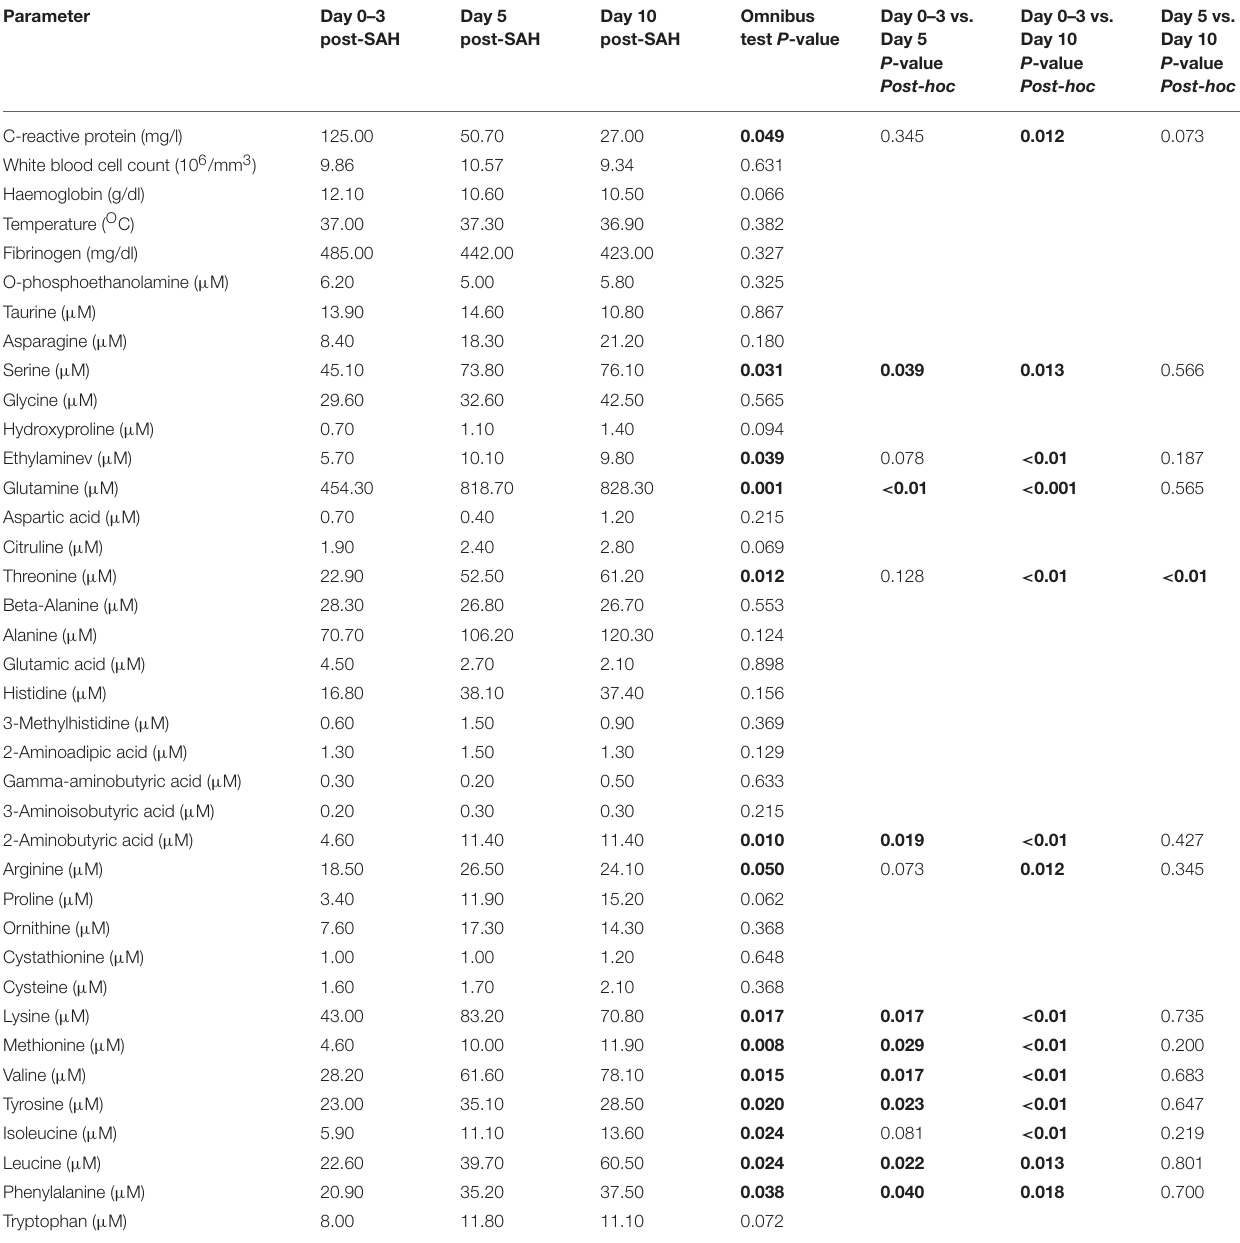
TABLE 4 | Amino acid level changes in time in good outcome SAH patients with (GO-SAH).